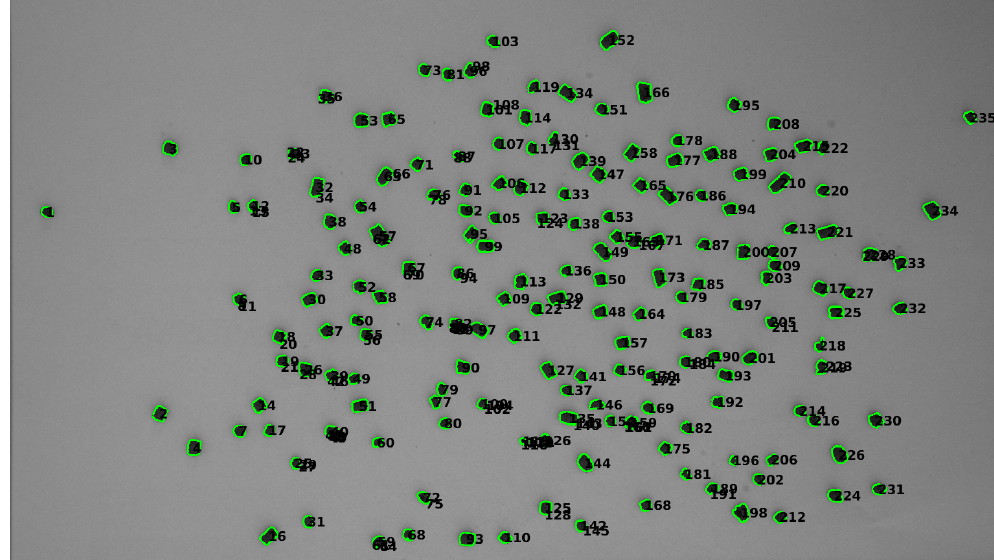
Figure 2. Measured pellet’s diameter using image